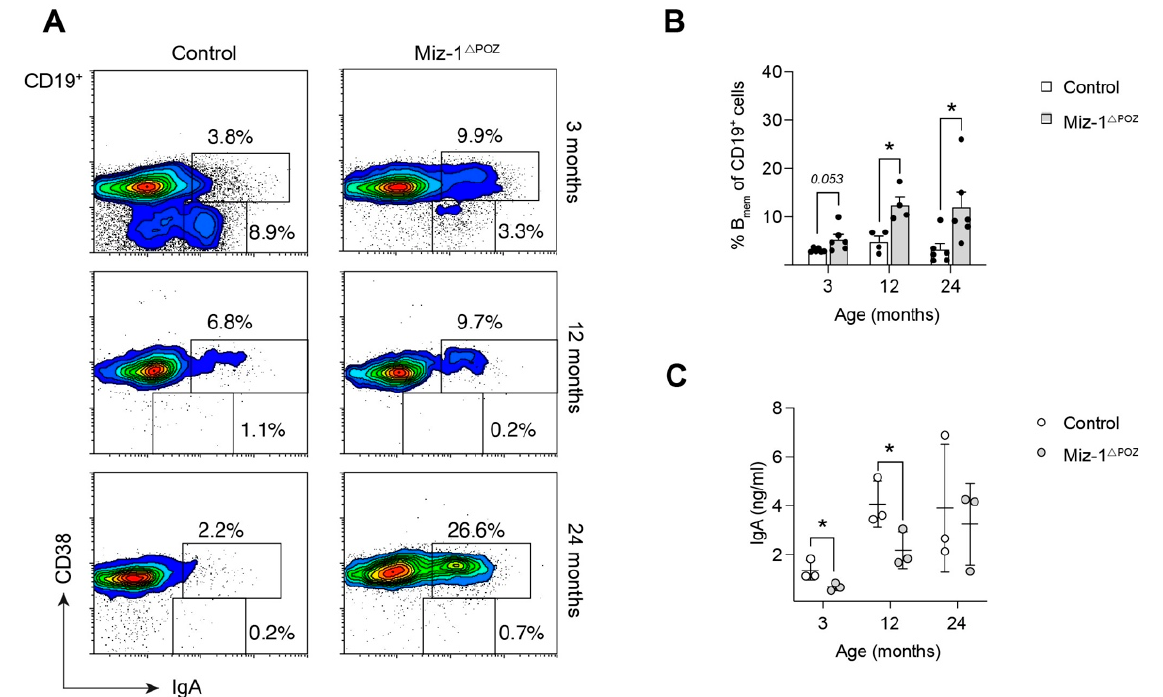
Figure 6. Antigen challenge boosts memory B cell differentiation at mucosal sites. ( A ) Flow cytometric analysis of single cells from macroscopic Peyer’s patches of control and Miz-1 Δ POZ mice at different ages. Percentages in plots are given for the respective gates as percentage per parent (CD19 + ). ( B ) Frequency of memory B cells (B mem , CD19 + CD38 + IgA + ) in relation to total CD19 + cells in PPs. ( C ) ELISA for fecal IgA from non-immunized control and Miz-1 Δ POZ mice. Analysis was performed in technical duplicates and each point represents the mean for one mouse. Each point represents one mouse. Data are expressed as mean + SD ( n ≥ 4). Student’s unpaired t -test: * p < 0.05. For ( A ), plots are representative of at least four independent experiments.